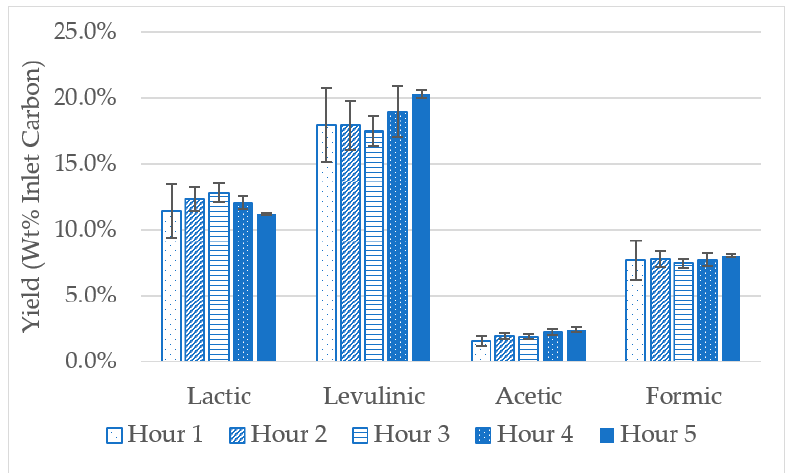
Figure 3. The effect of reaction time on organic acid yields from the Sn-Beta facilitated reaction of glucose at 200 °C, a 2:1 catalyst to sugars ratio, and no additives.